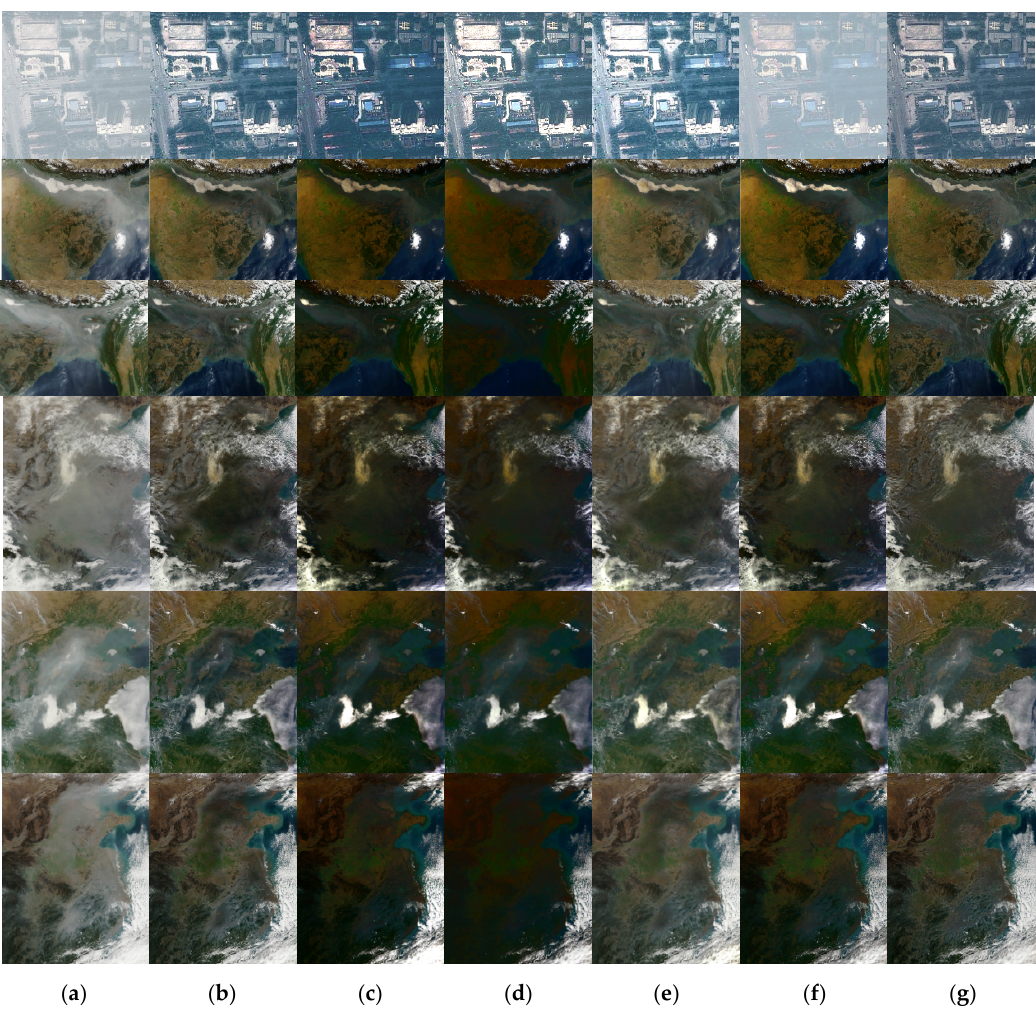
Figure 16. Comparison of visual assessment. ( a ) Original haze image, ( b ) He et al. [8], ( c ) Long et al. [16], ( d ) Wang et al. [11], ( e ) Pan et al. [17], ( f ) Wei et al. [12], ( g ) proposed method.